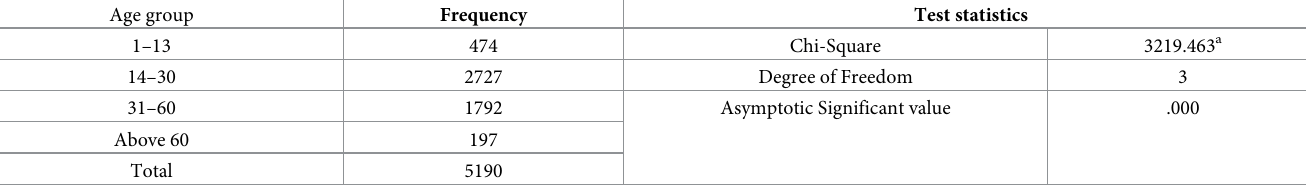
Basic Pay Scale (BPS: 1–20) wise distribution of